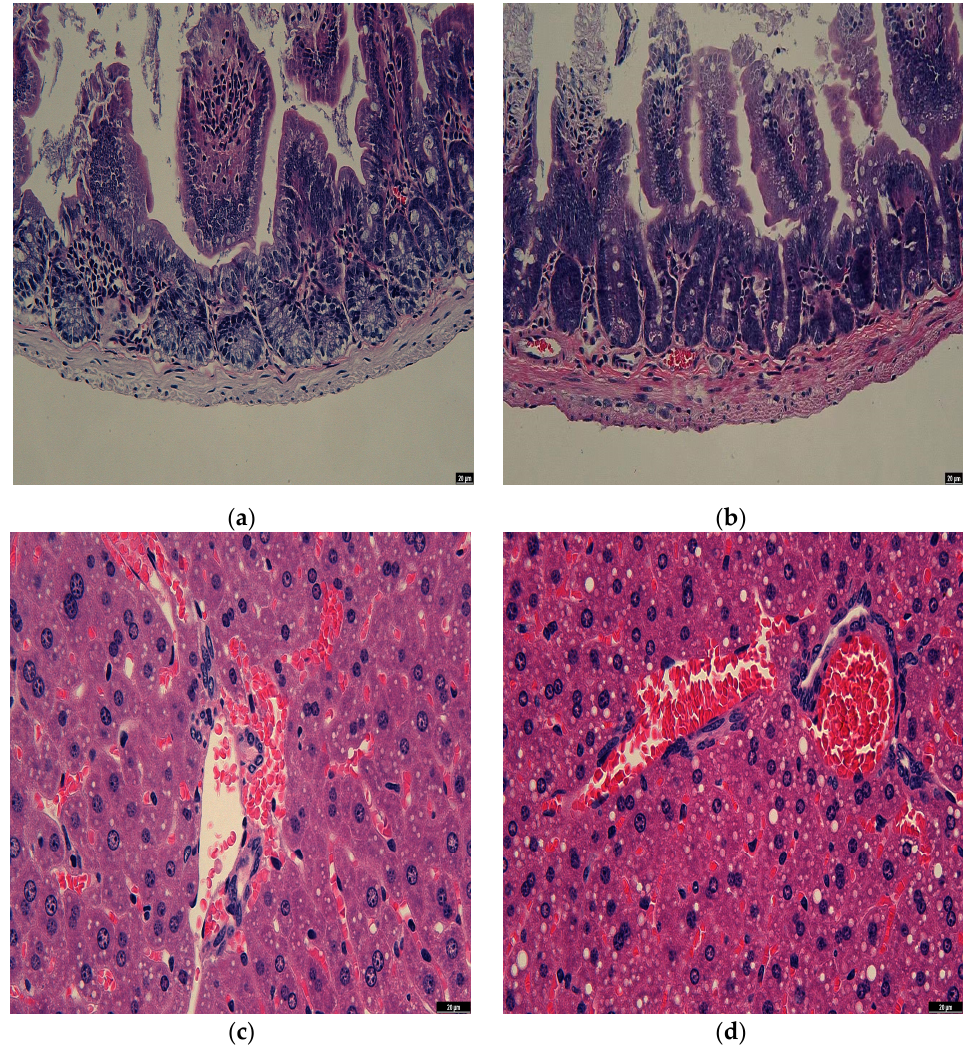
Figure 2. Results of rat tissue sections. ( a ) small intestine without Enterococcus faecalis DH9003 treatment; ( b ) small intestine with Enterococcus faecalis DH9003 treatment; ( c ) liver without Enterococcus faecalis DH9003; ( d ) liver with Enterococcus faecalis DH9003 treatment.